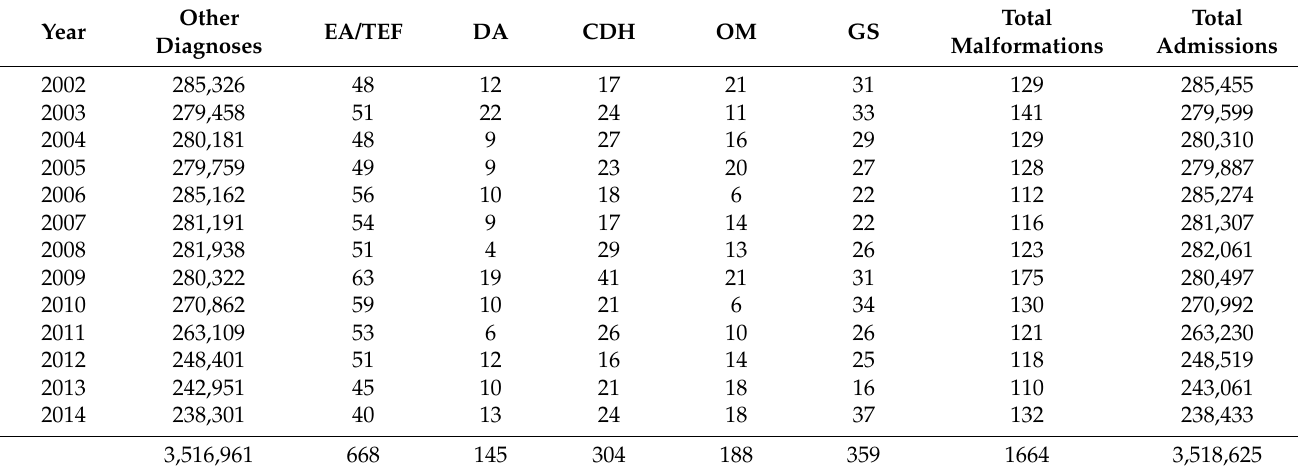
Table 1. Number of hospitalizations by year and considered congenital malformations (EA/TEF: esophageal atresia; DA: duodenal atresia; CDH: congenital diaphragmatic hernia; OM: omphalocele; GS: gastroschisis). Year